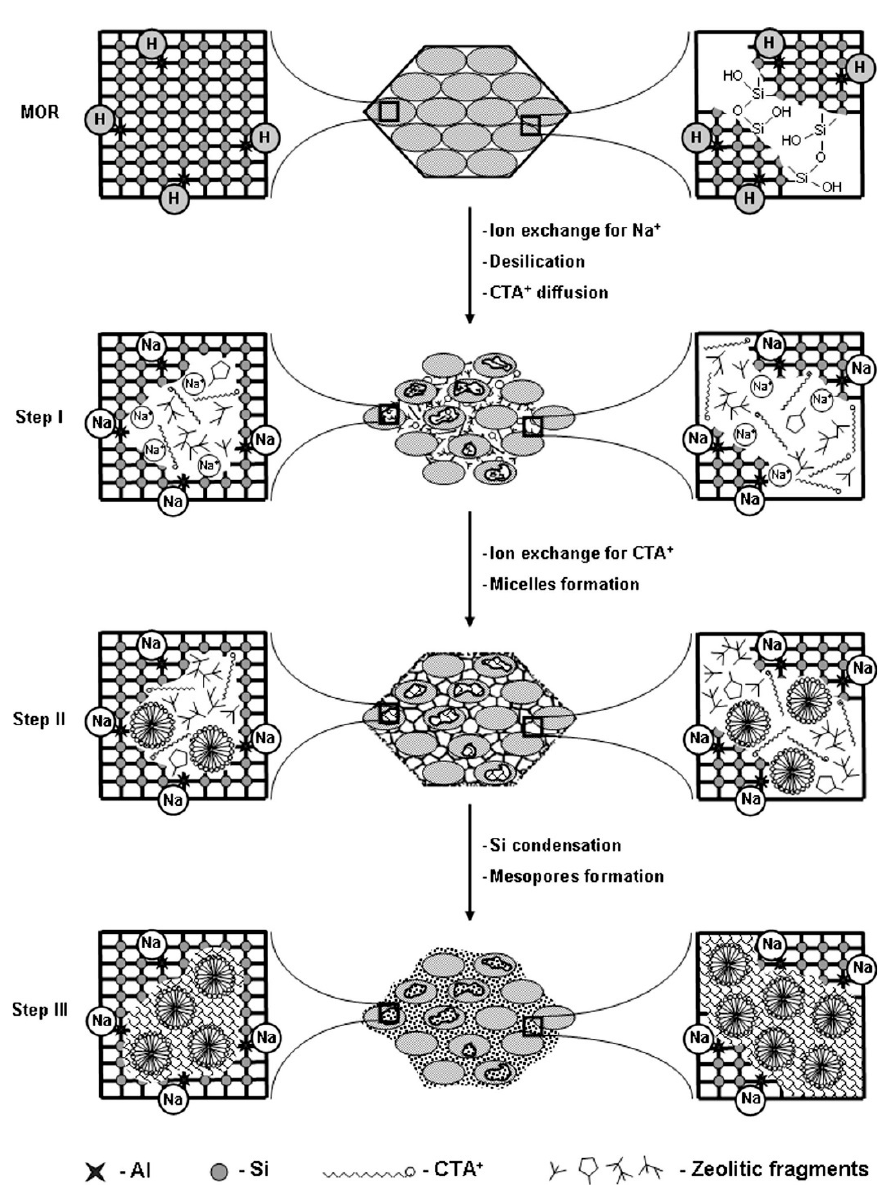
Figure 8. Proposed mechanism of the recrystallization of mordenite zeolite [102]. Copyright (2014), with permission from Elsevier.